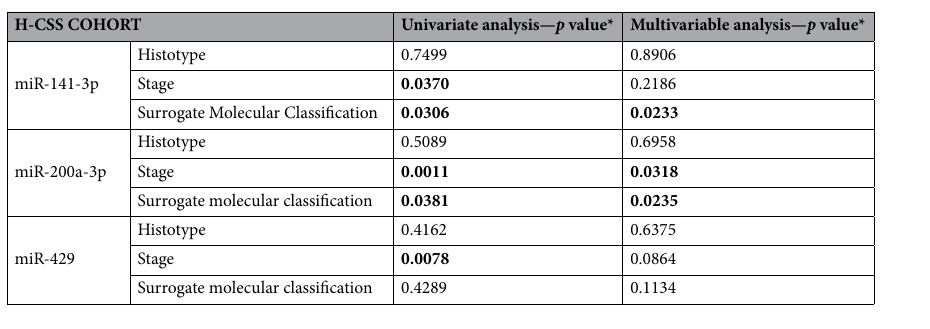
Table 3. Univariate and multivariable analysis of the association between miRNAs and clinicopathological characteristics in the TCGA cohort. * p -values <0.05 are reported in bold.